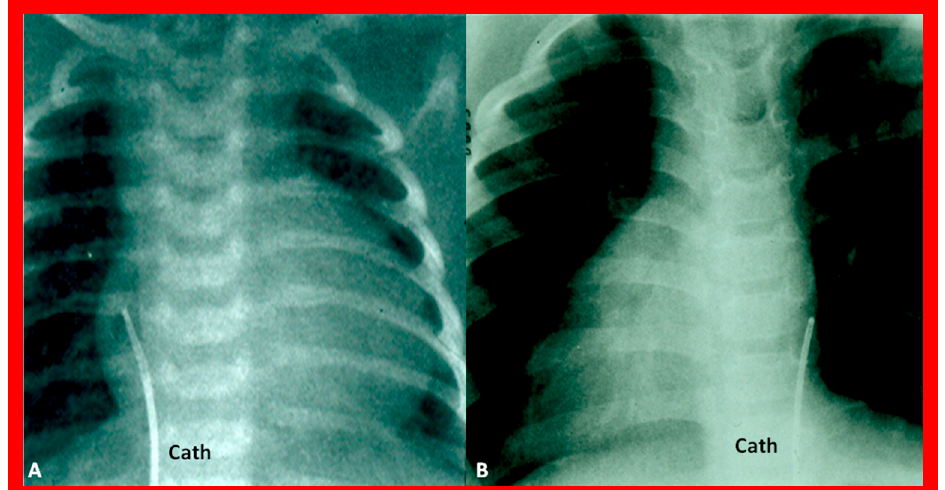
Figure 28. Cinefluoro images in posteroanterior views, illustrating positions of the catheters (Cath) in the inferior vena cava as they enter the right atrium (not labeled) in a patient with situs solitus ( A ) and another patient with situs inversus ( B ). Reproduced from reference